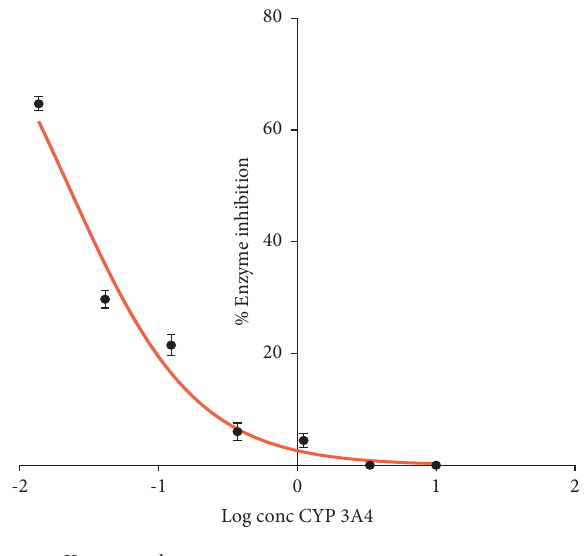
Figure 8: Dose-response curve of ketoconazole on the inhibition of CYP 3A4. Ketoconazole was used as the standard drug and various concentrations were used to determine the IC 50 values. Data are presented as mean ± S.E.M.